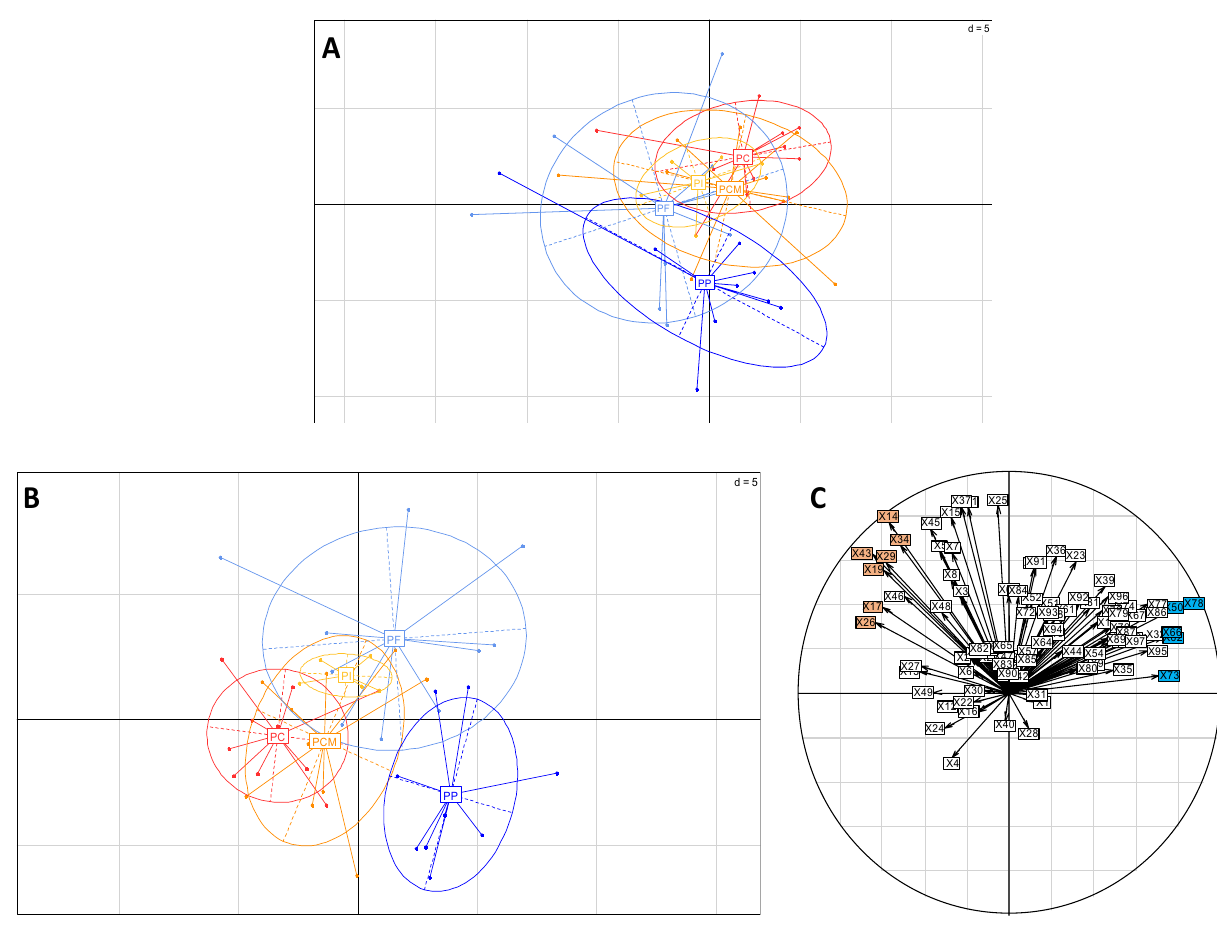
Figure 1. ( A ) PCA (axis 1: 19.6%; axis 2: 13.1%) achieved on 97 integrated UV peaks at 280 nm. The extracts obtained from the 44 strains isolated from 34 CF patients are displayed according to strain types: PP (strains from patients never colonised by Pa ; dark blue), PF (strains from patients not colonised by Pa during at least one year before; blue); PI (patient intermittently colonised by Pa ; yellow), PC and PCM (patient chronically colonised by Pa ; red and orange respectively). ( B ) PLS-DA (axis 1; axis 2) obtained from 97 integrated UV peaks at 280 nm according to strain types. The extracts obtained from the 44 strains PP, PF, PI, PC and PCM. ( C ) Correlation circle (axis 1; axis 2). Colored peaks correspond to discriminant peaks between first colonisation strains (PP/PF) and chronic strains (PC/PCM), in blue for those that are more detected in first colonisation strains and in orange for those that are more detected in chronic